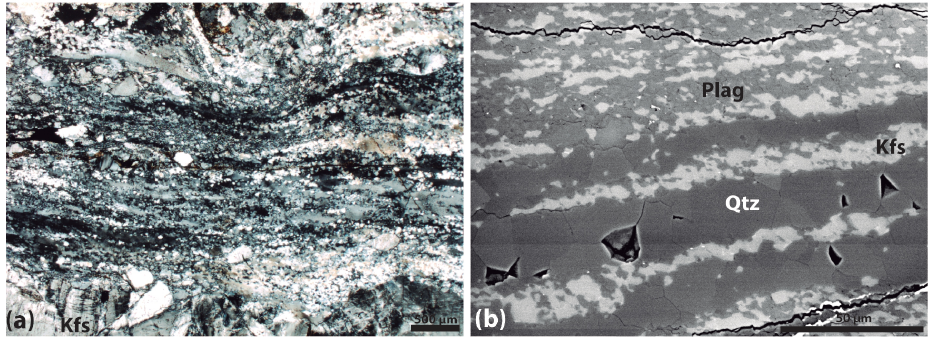
Figure 5. Optical and SEM microstructures of quartz veins and ribbons: (a) quartz monomineralic vein in contact with feldspar porphyro- clasts; (b) SEM-BSE image of a C’ band showing the overall distribution of phases in the contact with the quartz ribbon.